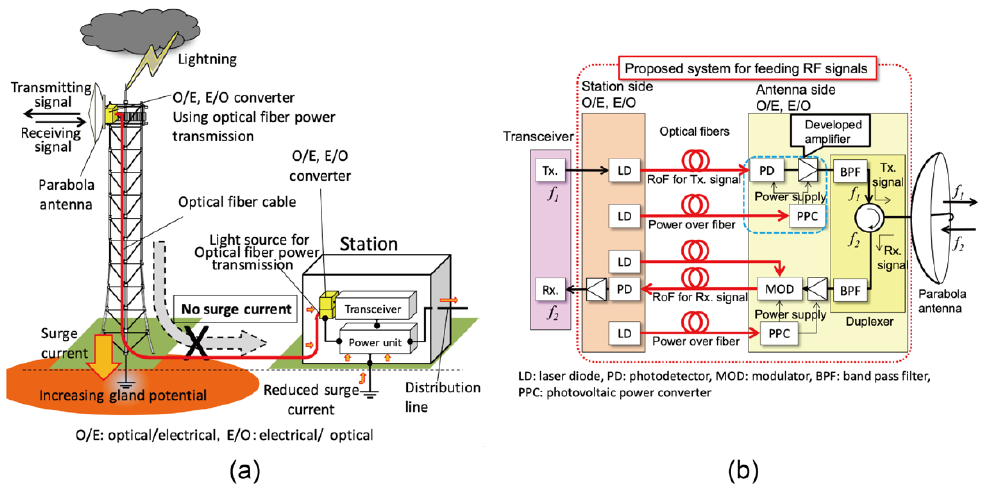
Figure 8. Configurations of ( a ) optically powered radio station using optical fiber and ( b ) block diagram of PWoF system [47].